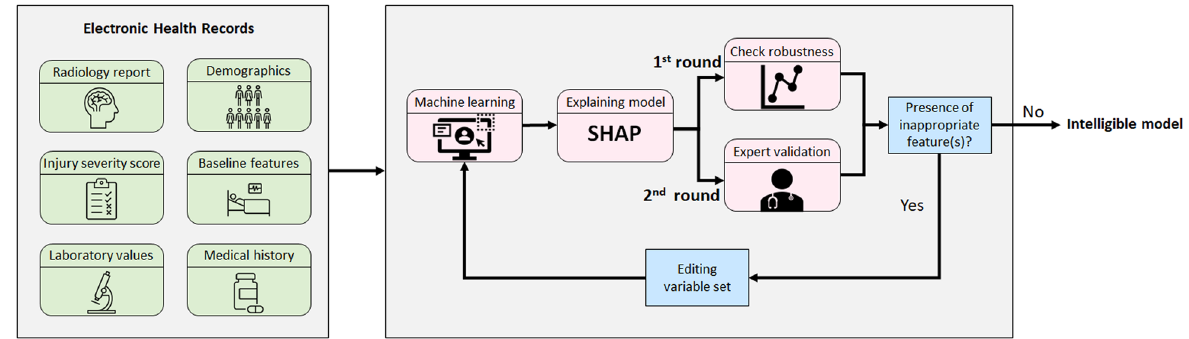
Fig. 5 The proposed framework for developing an intelligible TBI prognostic model. After training an initial machine learning model, input features are selected based on statistical robustness and clinical validity. The machine learning model is retrained after each step of feature